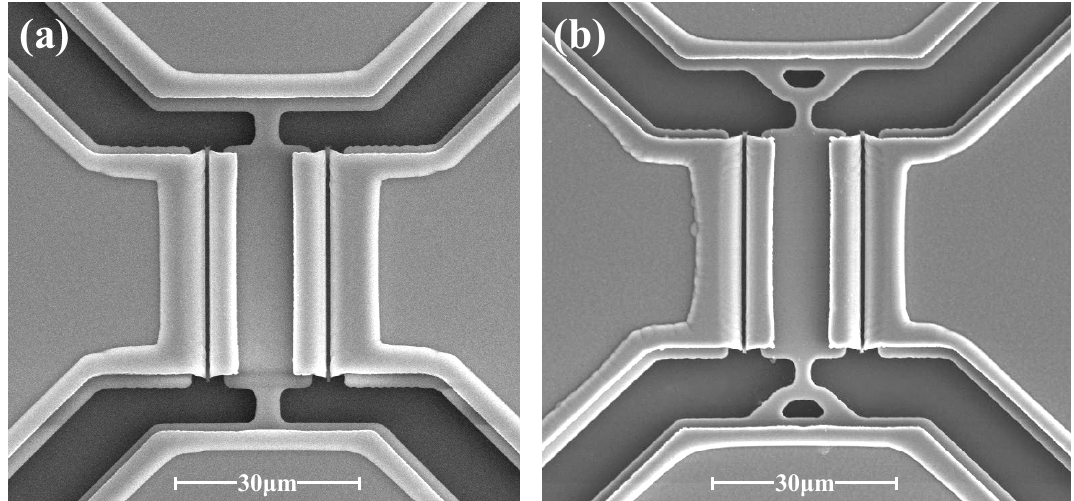
Figure 7. Process flow for the WEM resonators: ( a ) SOI wafer with a PECVD SiO as a mask, ( b ) the thermal oxide layer grown on the SOI wafer by dry etching, ( c ) the deposition of LPCVD polysilicon to form AC signal electrodes and ( d ) the deposition of thick Au/Cr electrode pads by e-beam evaporation and lift-off process.